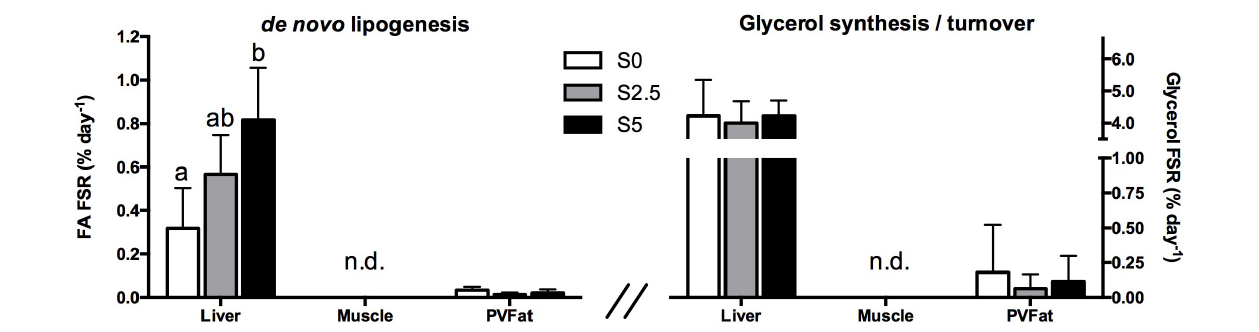
FIGURE 4 | Triacylglycerol-bound fatty acid fractional synthetic rate (FA FSR; de novo lipogenesis ) expressed as percent of newly synthesized fatty acids per day (left) and triacylglycerol-bound glycerol fractional synthetic rate (Glycerol FSR; glycerol synthesis/turnover) expressed as percent of newly synthesized/turned over glycerol per day in hepatic, muscular and perivisceral TAG of European seabass ( Dicentrarchus labrax ) fed with different levels of glycerol (0, 2.5, and 5%) after a 6-day residence in a tank with ∼ 4% 2 H-enriched water. Mean values ± SD are presented ( n = 6). Significant differences between dietary treatments are indicated by different letters (one-way ANOVA, p < 0.05; followed by Tukey’s test). n.d.: not